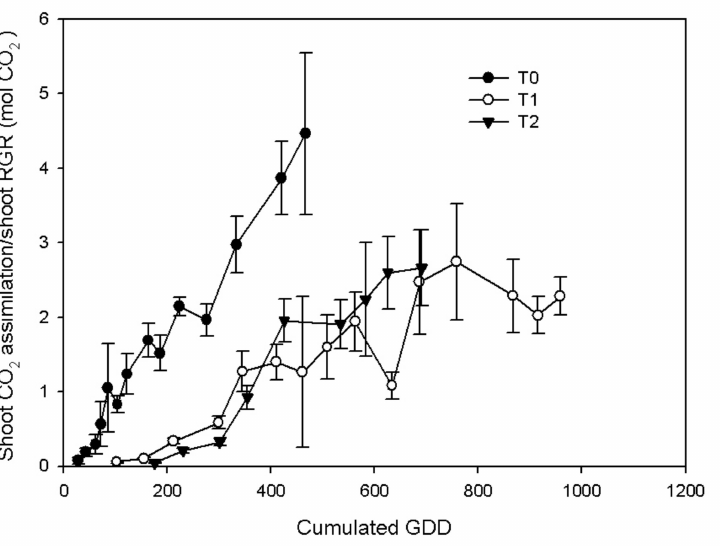
Figure 7. Shoot CO 2 assimilation/shoot RGR vs. cumulated GDD from budburst to shoot topping in T0, T1, and T2 vines ( n = 4). Mean ±